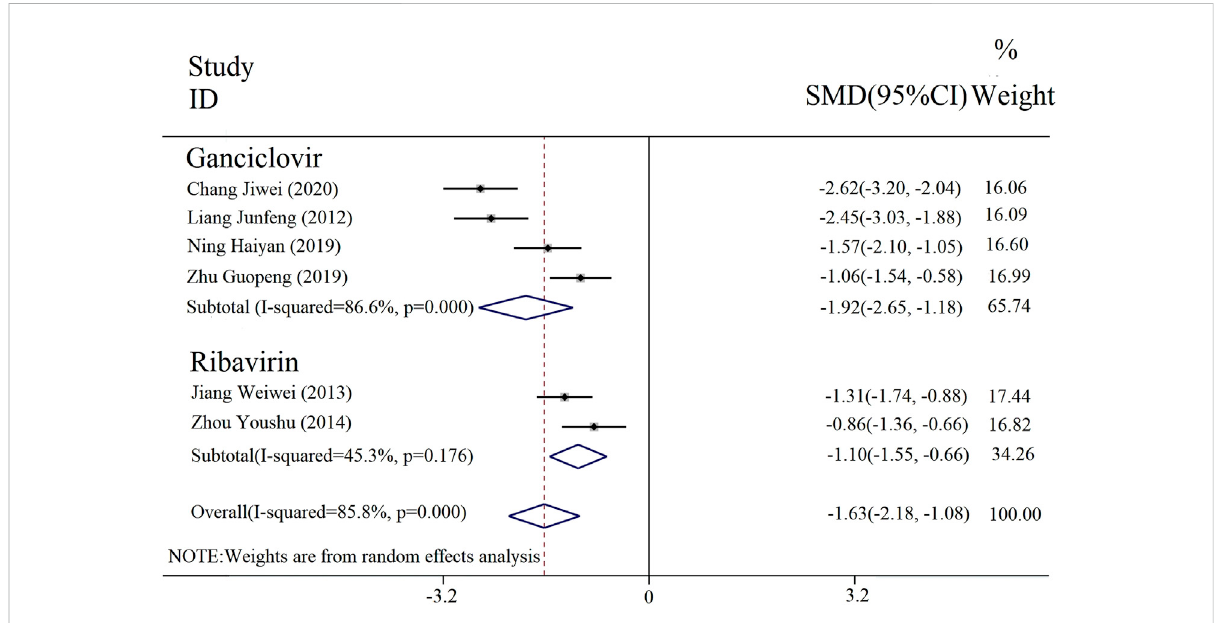
FIGURE 7 Forest plot of the duration of comparing the parotid gland pain among the groups.